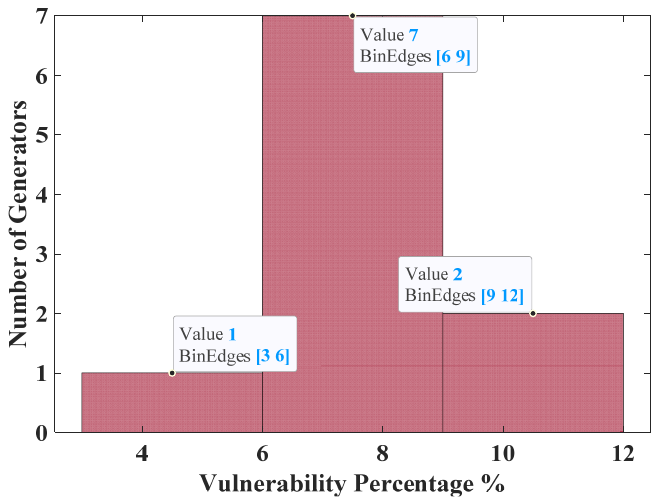
Figure 6. The vulnerability analysis of the generators for strategy 1.